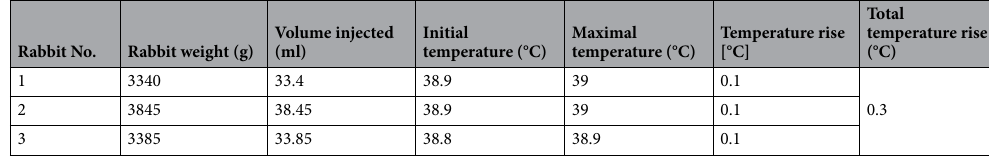
Table 14. Results of the pyrogenicity test.